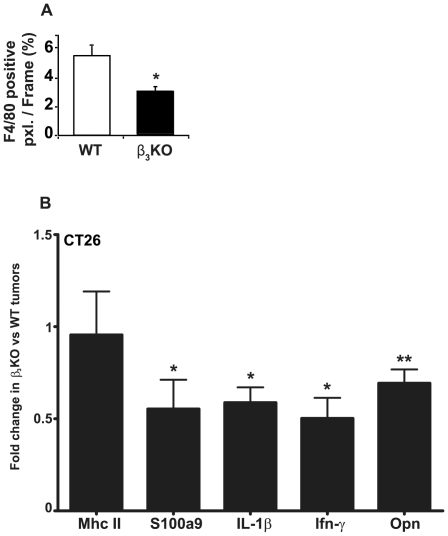
Inflammatory parameters in CT26 carcinomas.
A) Macrophage content in CT26 carcinomas. The fraction of F4/80 positive pixels per image frame is presented (n = 7 for each genotype, ×200 magnification). * indicates p<0.05 by Mann-Whitney test. Error bars are SEM. B) QRT-PCR analysis of pro-inflammatory genes in CT26 carcinomas grown in integrin β3-deficient (n = 12) compared to WT mice (n = 11). Bars indicate fold changes in tumors grown in integrin β3-deficient mice after normalization to tumors from WT mice using the 2−ΔΔCt method. * indicates p<0.04; ** indicates p<0.01 with Student's t-test. Error bars are SEM.